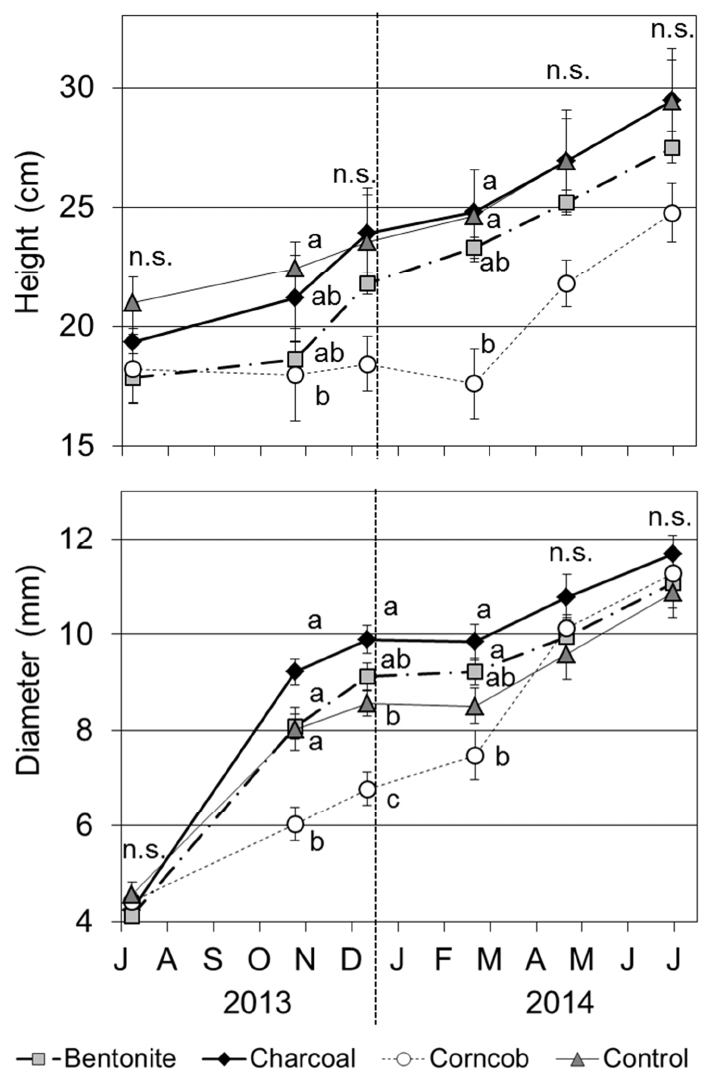
Figure 4. Tree height and basal diameter of teak seedlings grown in four treatments (Mean ± SE, n = 8). Note: divisions on horizontal axis over the letters are the first day of each month. The same